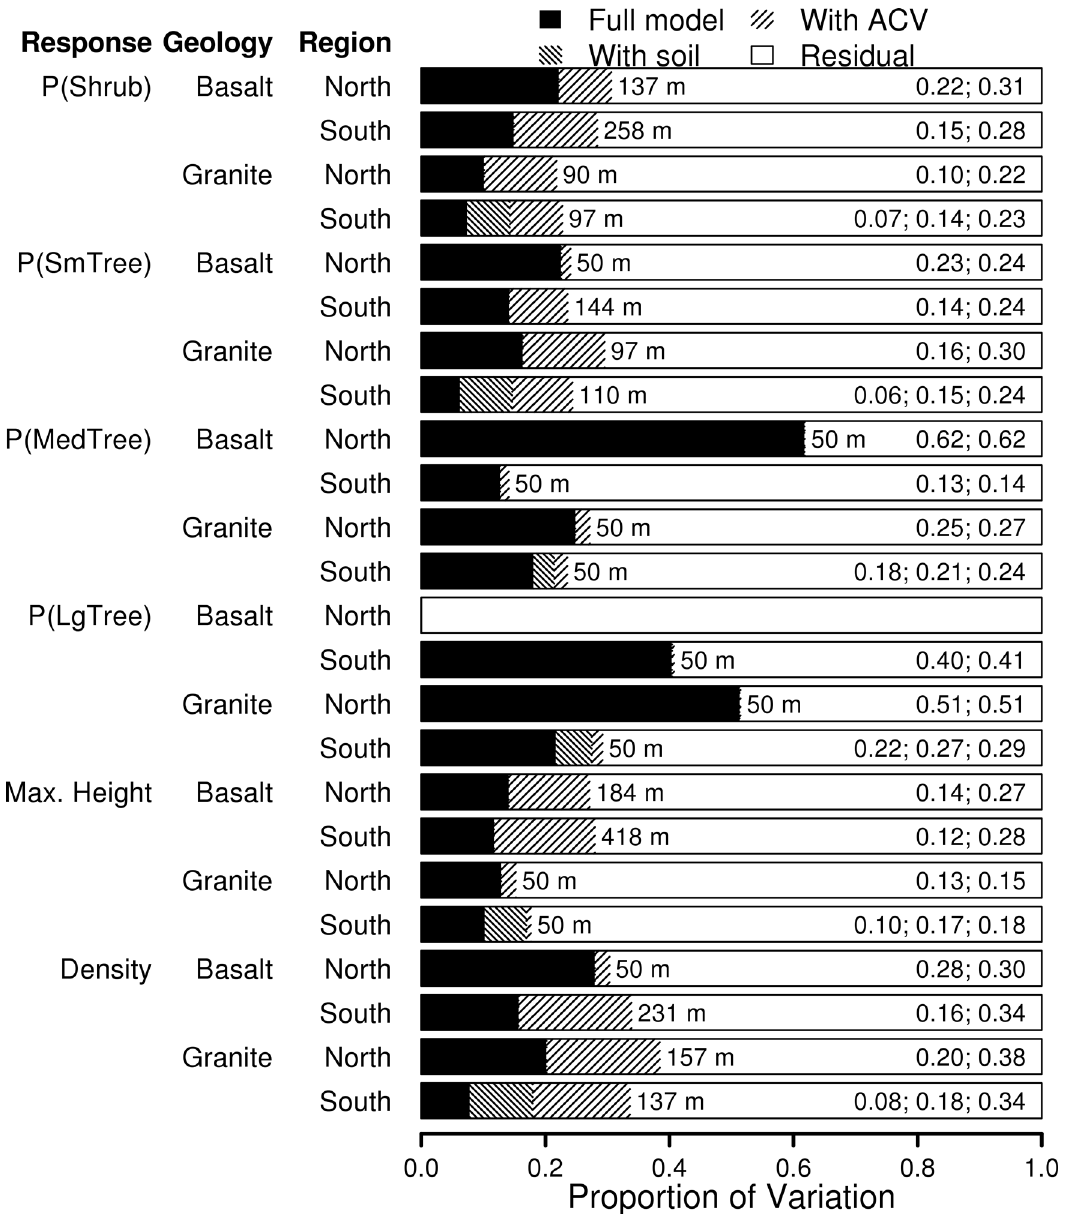
Fig 5. Variance explained by the models for the four watersheds. The proportion of variation, measured as R 2 , for all combinations of response variable and watershed. Values are given both before and after an autocovariate (ACV) was added to a full model with all environmental variables and one-way interactions. For the southern granite watershed, the total proportion of variance explained with soil class (STP) in the model — prior to the addition of and ACV term — is also shown. Bars represent the R 2 values given on the right side. The lag distance used to compute the ACV term for each model is given after each bar. One row is missing because there was too little large tree vegetation on the northern basalt site to fit a model. P(Shrub), P(SmTree), P(MedTree) and P(LgTree) refer to proportion of area in a 16.8 x 16.8 m window of the vegetation height map that is in the given height class: 0.5 to 2.5 m (shrub), 2.5 to 5.0 m (small tree), 5.0 to 10.0 m (medium tree), and > 10.0 m (large